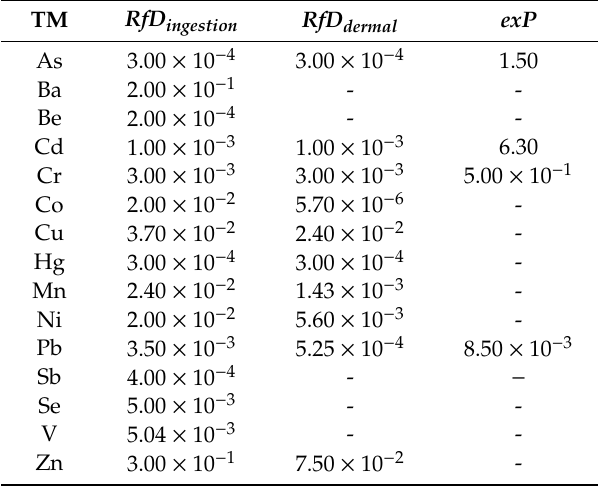
Table 3. Reference doses (RfD) in mg / kg / day, and Cancer Slope Factors (exP) for the di ff erent trace metals